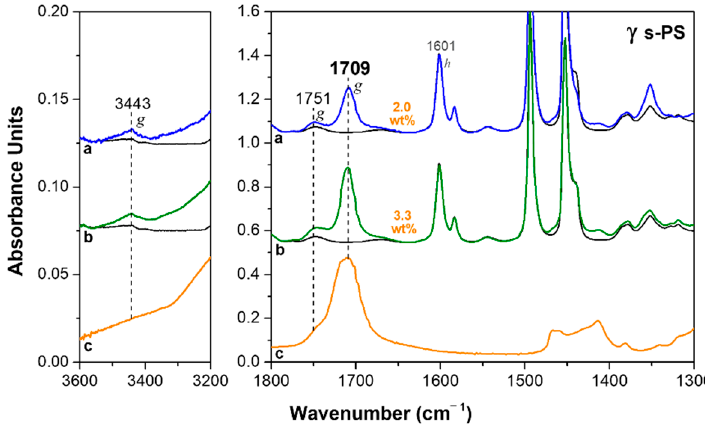
Figure 2. FTIR spectra of an axially oriented γ form s-PS film after immersion in: ( a ) HA at 70 ◦ C for 12 h; ( b ) 40 wt% solution of HA in acetone at room temperature for 12 h, followed by acetone desorption at 50 ◦ C for 1 h. The uptake of HA in the film (expressed as wt%) is indicated close to the spectra. The FTIR spectrum of liquid HA is shown for comparison in ( c ).